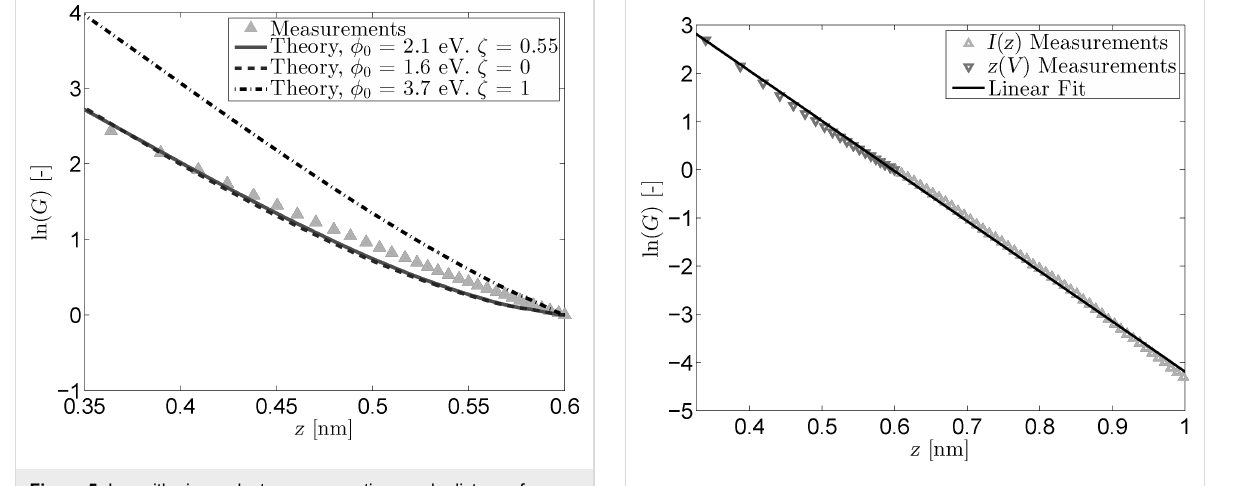
Figure 5: Logarithmic conductance versus tip-sample distance for measured and reconstructed z ( V ) data. The reconstructed traces were based on the fit parameters from Figure 4. The logarithmic offsets have been subtracted so that ln( G ) = 0 at z 0 = 0.6 nm.